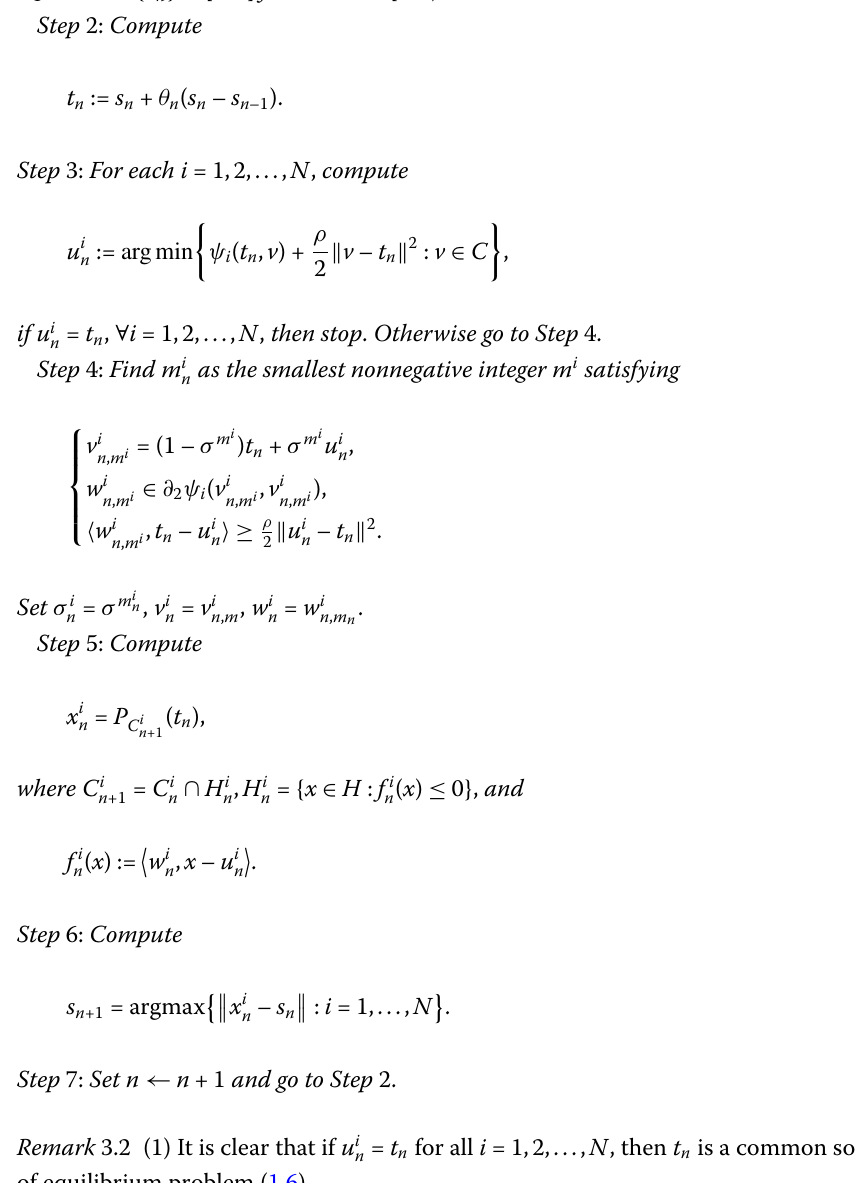
Algorithm 3.1 Step 1: Choose σ ∈ (0,1), ρ > 0. Select arbitrary points s 0 ∈ C 0 , s 1 ∈ C 1 ; C 0 = C 1 = C and { θ n } ⊂ [0, θ ] for some θ ∈ [0,1). Set n :=